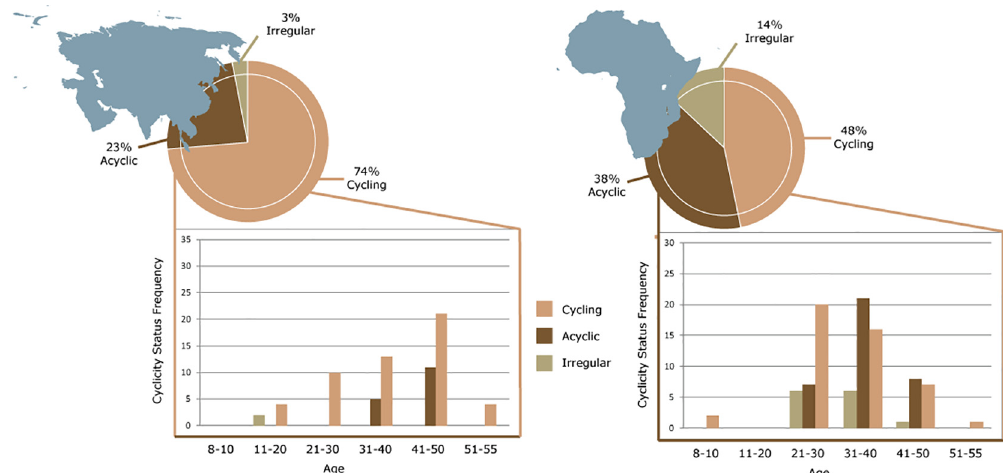
Fig 2. Proportion of normal cycling, irregular cycling and acyclic elephants in the study population for Asian (left) and African (right) elephants in pie charts, and below each pie chart is a further breakdown by age categories for each species.